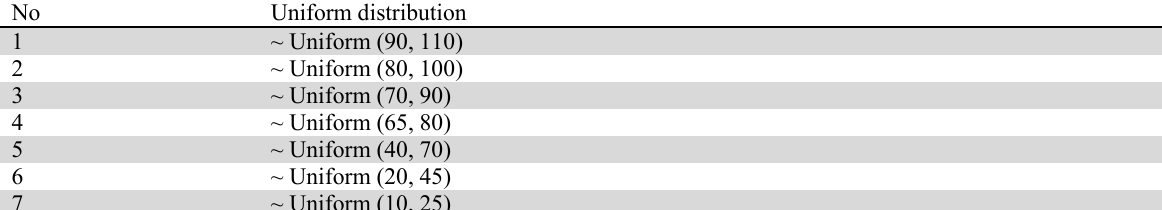
Uniform distribution used in sensitivity analysis of donation capacity